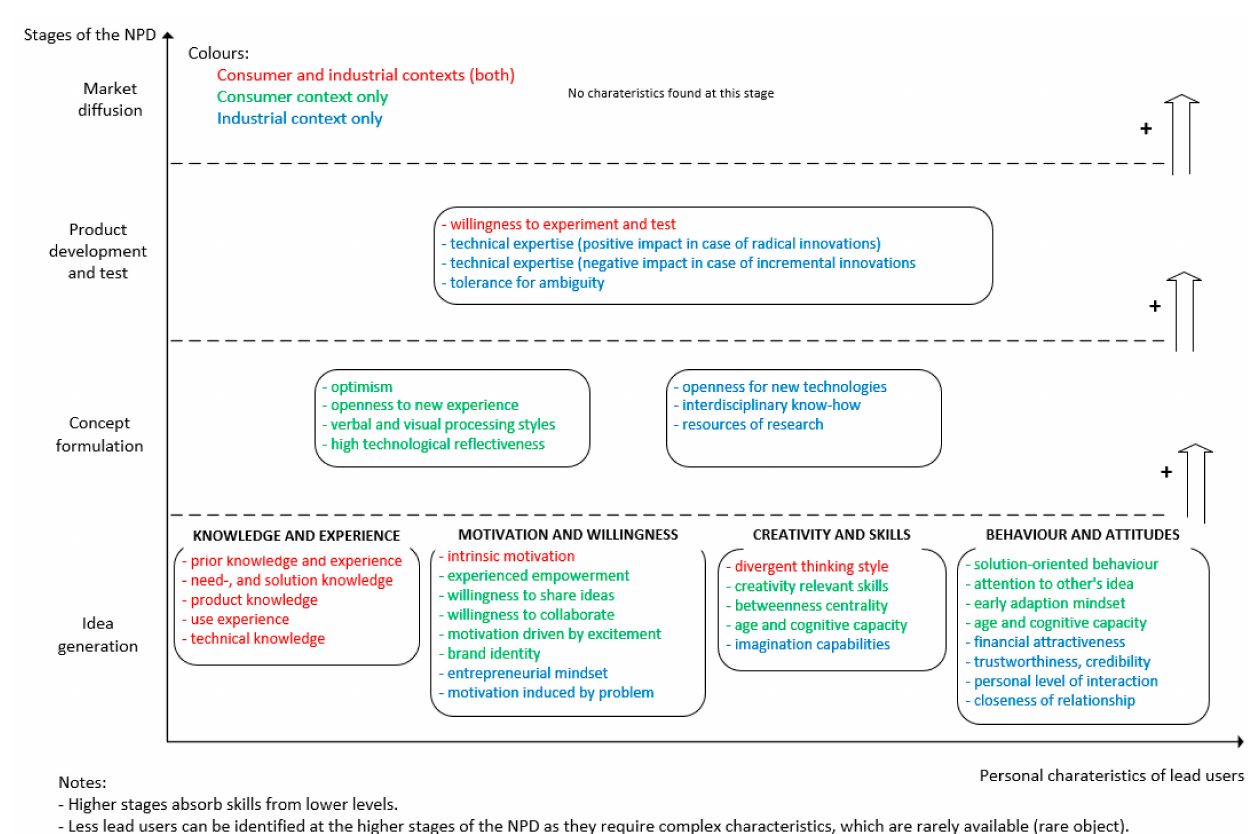
Figure 4. Required personal characteristics of lead users in different stages of the NPD